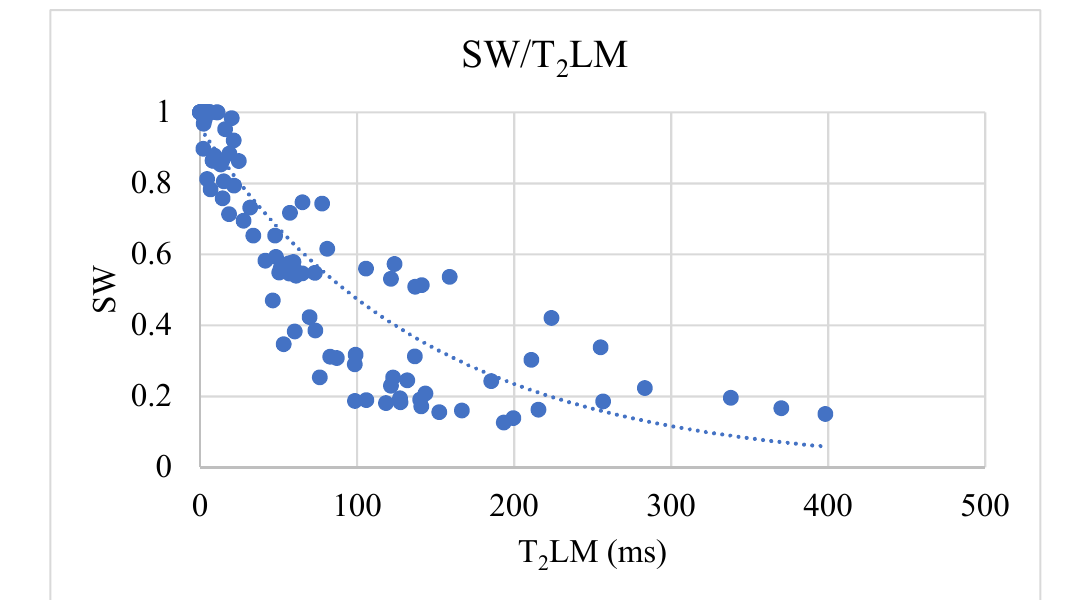
Figure 19. Predicted NMR T 2 LM for Reservoir B in new well.